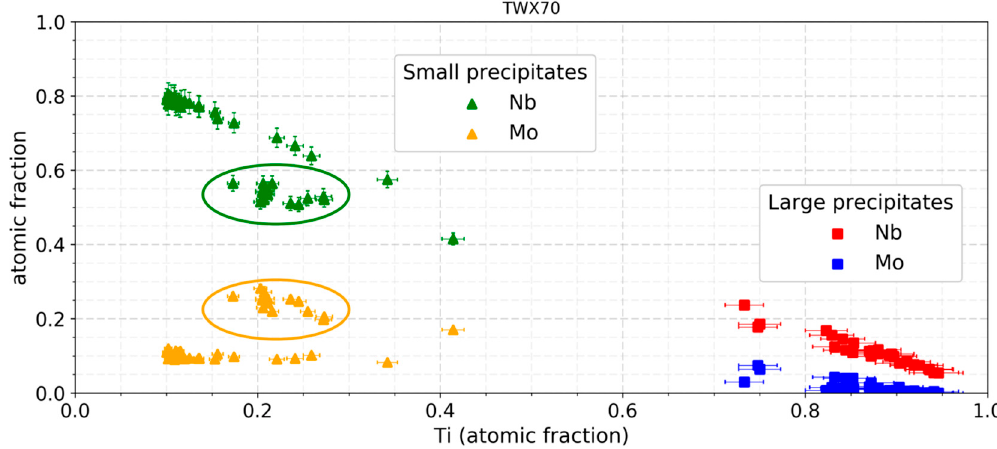
Figure 5. Atomic fraction for TWX70 steel precipitates measured using EDX analysis.